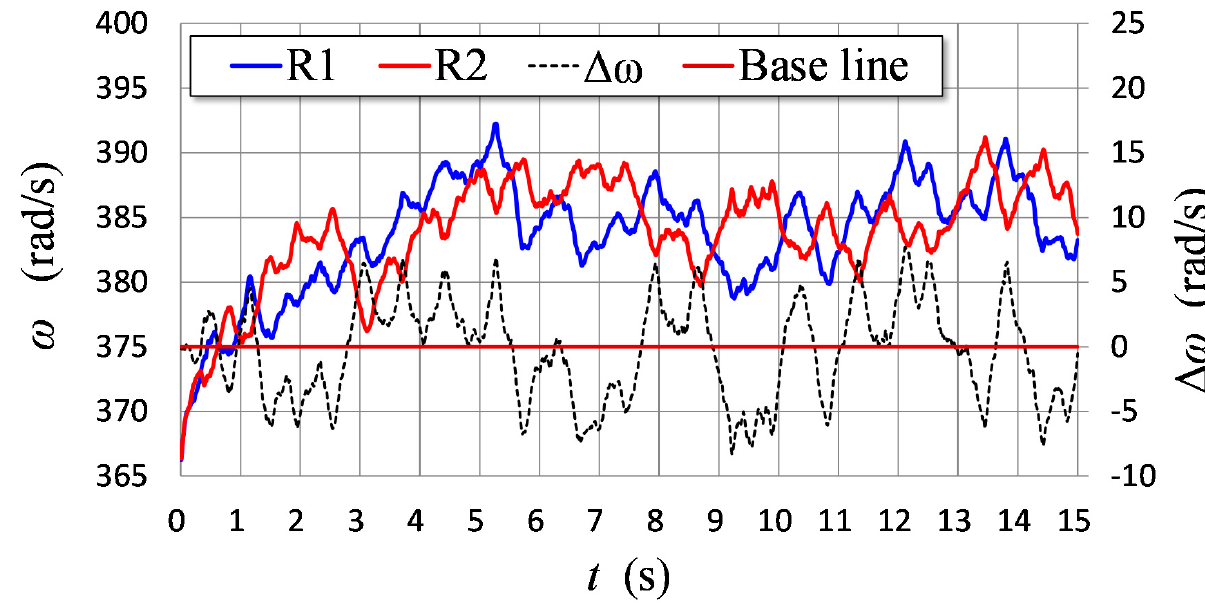
Figure 19. Out-of-phase state for angular velocities of two rotors in CD layout with gap / D = 0.3. Next, the mechanism of phase synchronization generation was considered. Figure 20 shows the color contour of the flow velocity ( x -direction component) around the rotors in a state of phase synchronization in the CD layout with gap / D = 0.2, which corresponds to the data in Figure 17. As illustrated in Figure 20, the blades of the two rotors rotated in phase. The fluid accelerated in the area between the blades that approached the minimal gap between the two rotors. From this observation and based on Bernoulli’s law, the pressure was reduced in the area sandwiched by the approaching blades. Consequently, the approaching blades with some phase difference mutually generated attractive forces, as illustrated in Figure 21; a delayed blade was accelerated and a leading blade was decelerated; this state might alternate at a constant period. Consequently, variations occurred in the angular velocity and torque, as shown in Figures 17 and 18.